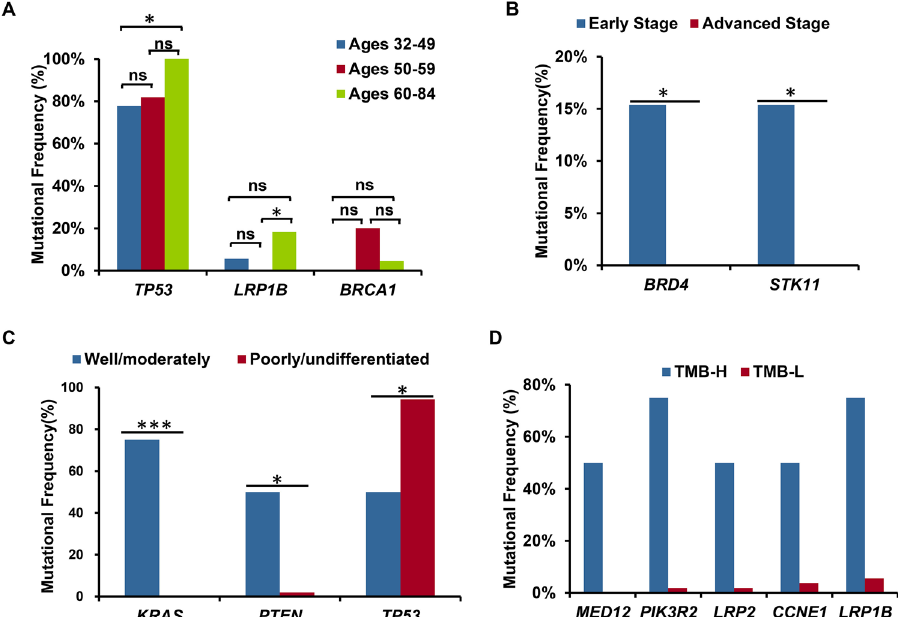
Figure 2. Correlated analysis of mutated genes and clinical characteristics. ( A ) Correlation analysis of mutated genes and the age of patients; ( B ) Correlation analysis of mutated genes and tumor stage; ( C ) Correlation analysis of mutated genes and tumor differentiation; and ( D ) Correlation analysis of mutated genes and TMB. The X-axis shows the mutated genes and the Y-axis represent the mutational frequency of each gene. Fisher’s exact test was used to analyze significant differences and bonferroni correction were performed for multiple test correction. ns P > 0.05, * P < 0.05, ** P < 0.01, and *** P < 0.001.